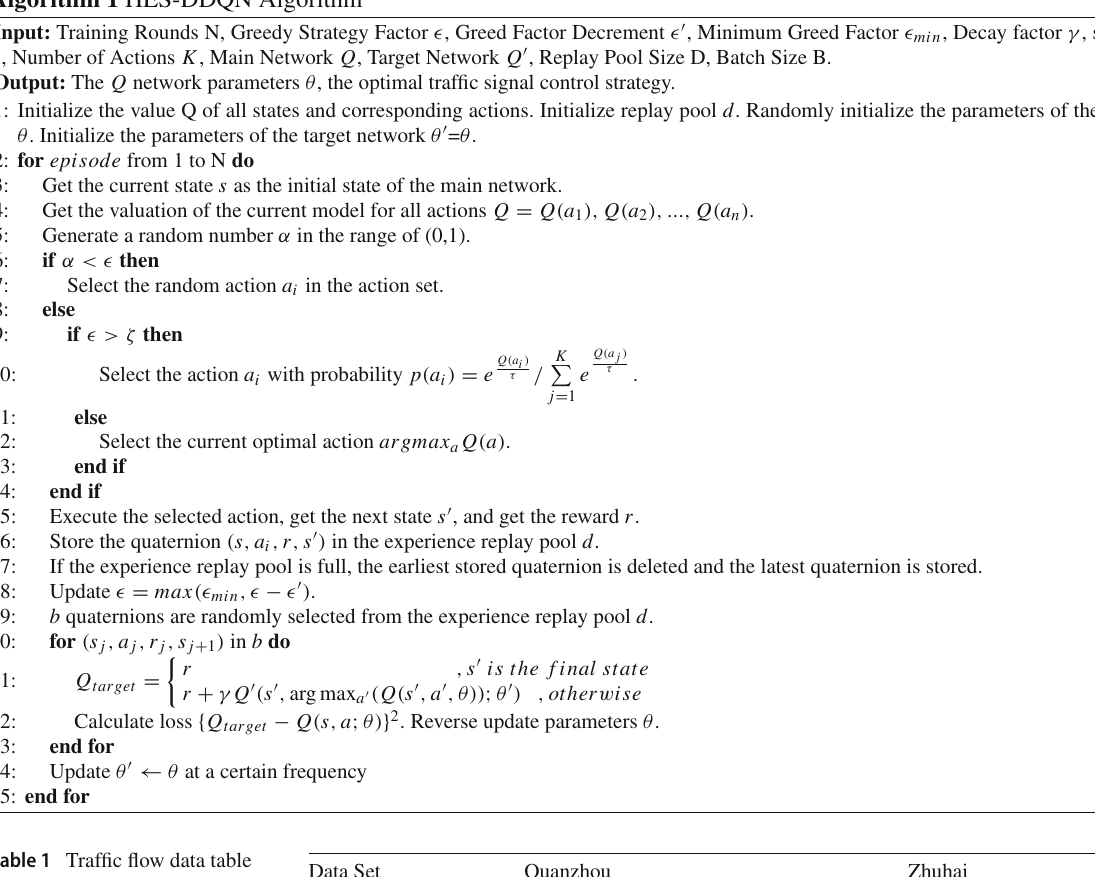
Algorithm 1 HES-DDQN Algorithm